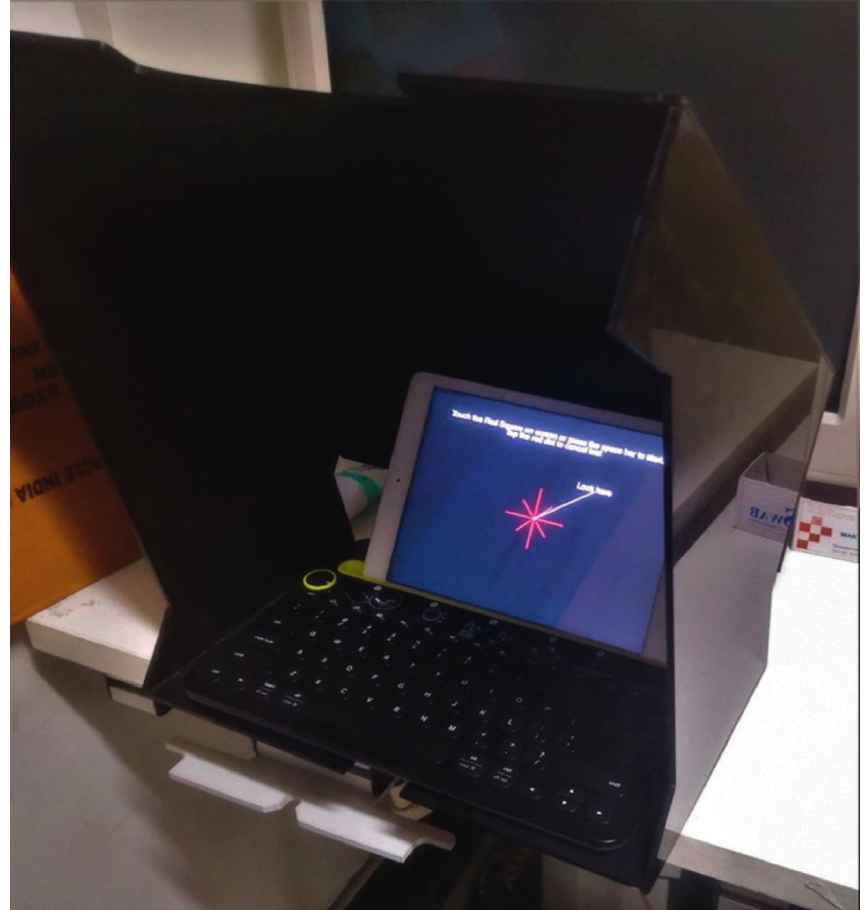
Figure 3: The iPad-keyboard-viewing-shield apparatus with a headrest maintaining 33cm viewing distance for Melbourne Rapid Fields (MRF)